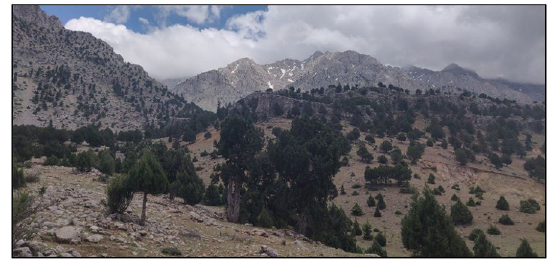
Fig. 8 A section of the narrow and deep valleys recorded at 2500 m in the Dagdibi neighborhood of Karanfil Mountain and its surroundings